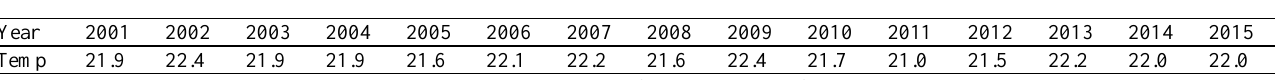
Table 2. The annual average LST of Fujian Province from 2001 to 2015